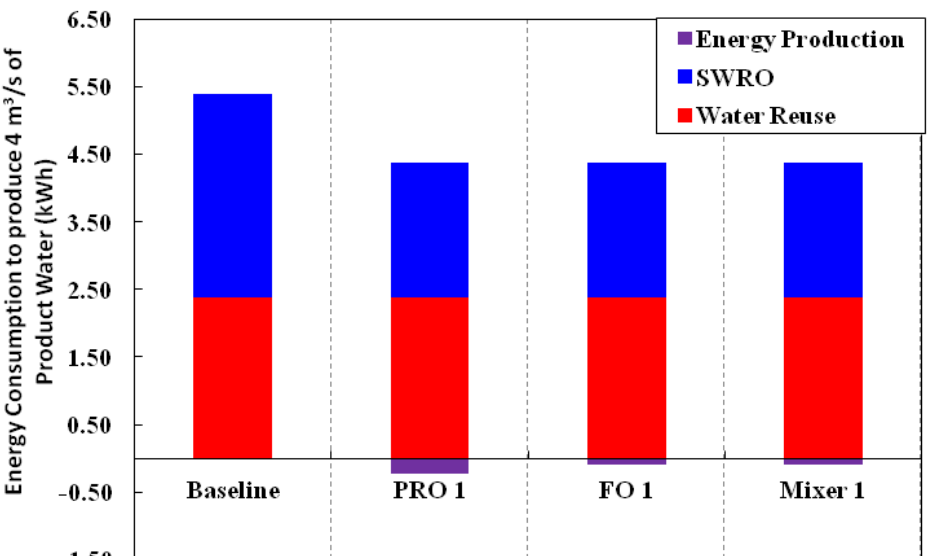
Figure 9. Comparison of the total energy consumption for the baseline and various configurations of the Hybrid